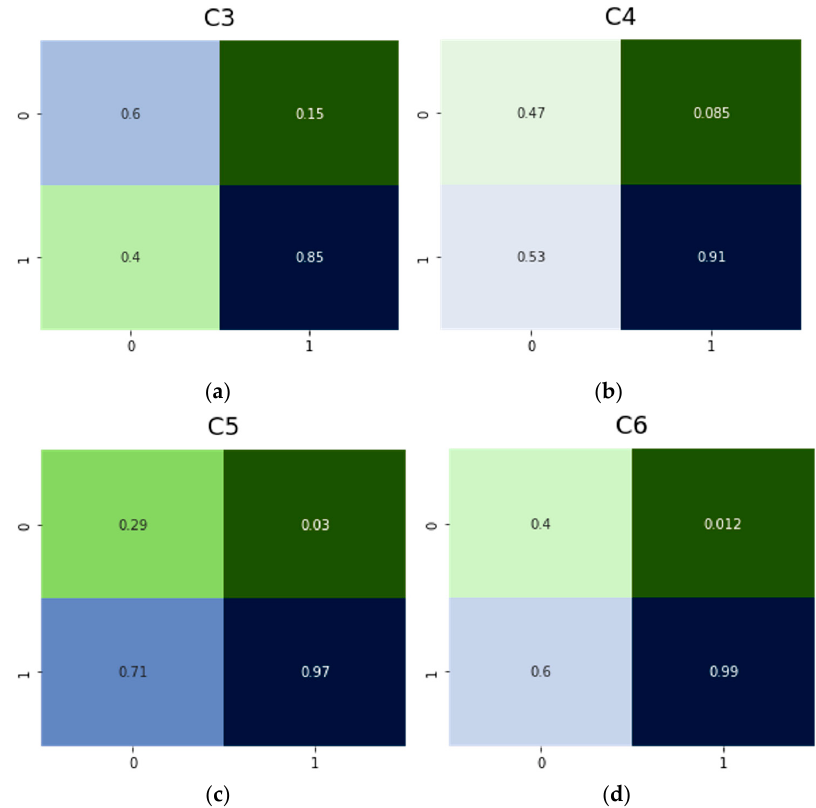
Figure 8. The multi-classification model based on Resnet50. The confusion matrices for C3 ( a ), C4 ( b ), C5 ( c ), and C6 ( d )